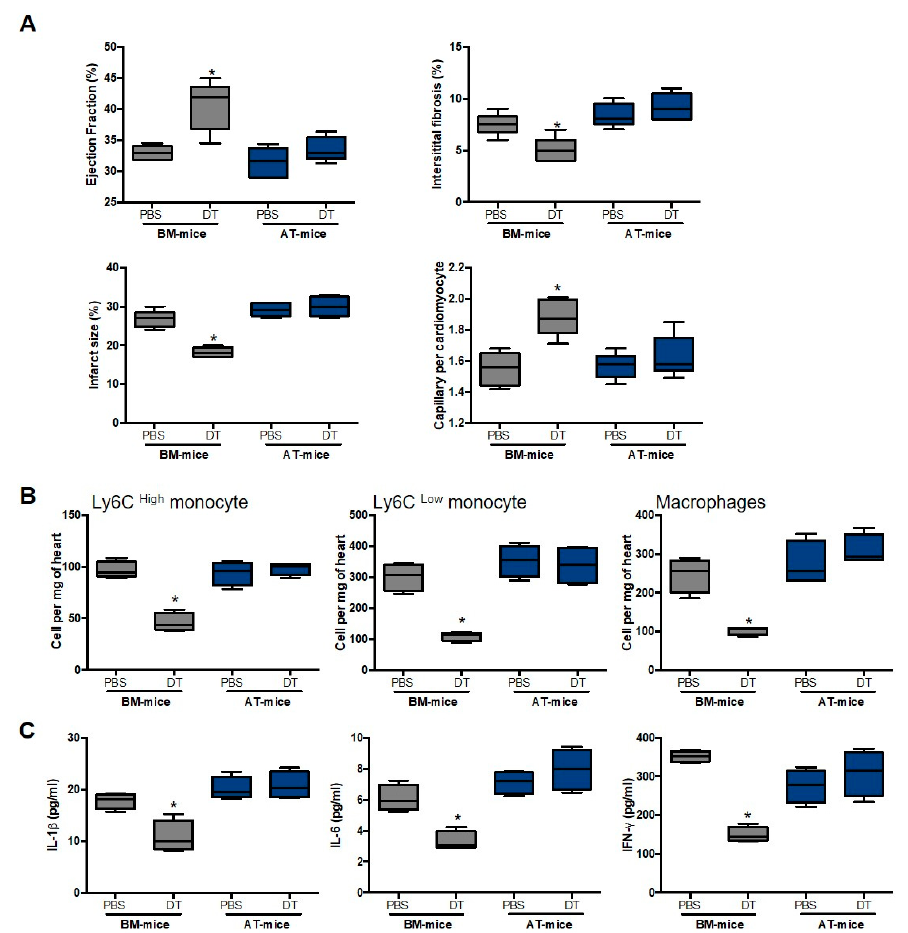
Figure 7. Adipose tissue-derived CD11c + macrophage depletion did not regulate cardiac function and remodeling in diabetic mice. ( A ) Ejection fraction, interstitial fibrosis, infarct size and capillary density in diabetic BM- and AT-chimeric mice treated with or without diphtheria toxin (DT) (n = 6–8). ( B ) Monocyte and macrophage number in the heart of diabetic BM- and AT-chimeric mice treated with or without DT, (n = 6–8). ( C ) IL-1 α, IL-6 and IFN γ levels in the heart of diabetic BM- and AT-chimeric mice treated with or without diphtheria toxin (DT) (n = 4–6). Comparisons between groups were performed using Dunn’s multiple comparisons test (* p < 0.05 in DT vs PBS treated mice).